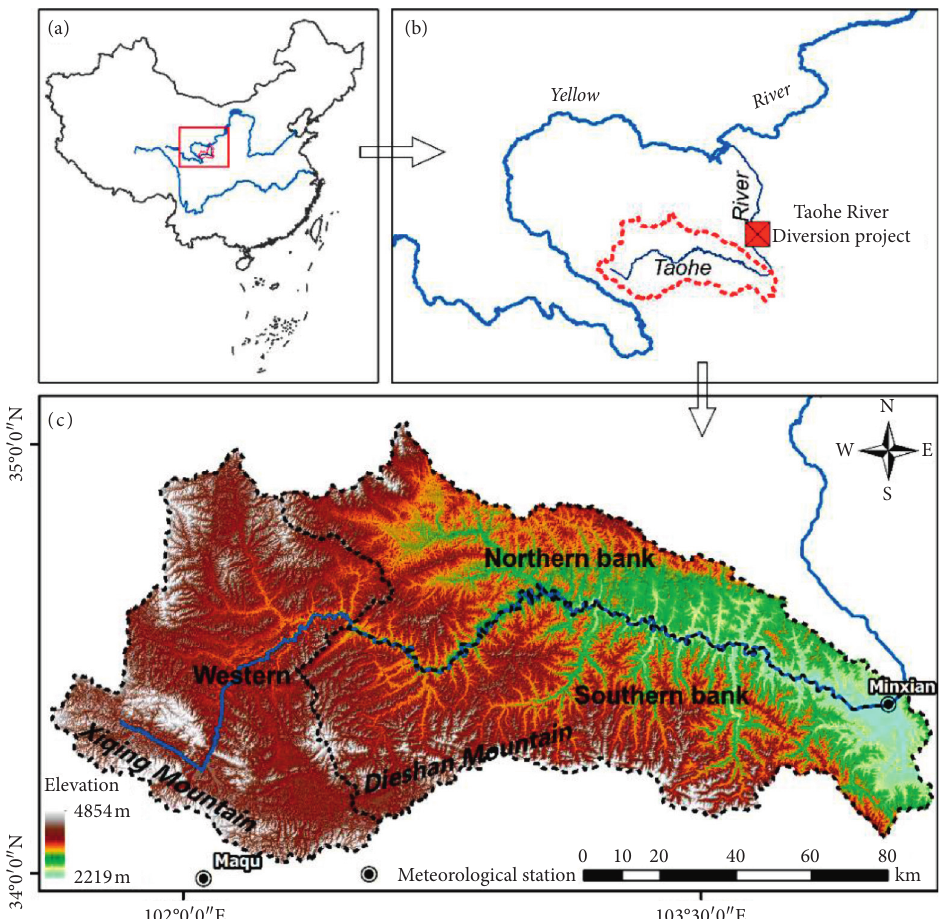
Figure 1: Location of the upper Taohe River basin and the divided three subzones: western zone, northern zone, and southern